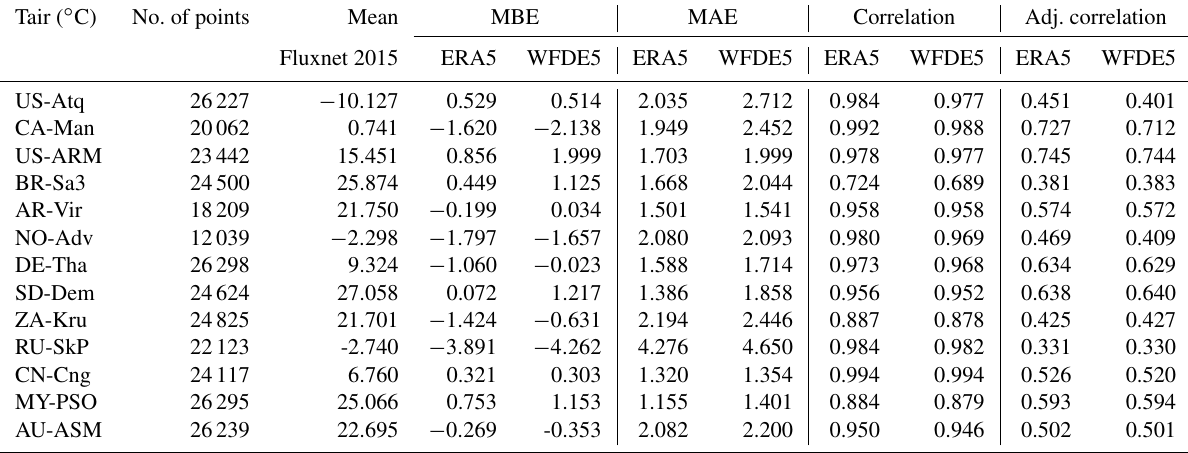
Table A1. Tair metrics for each FLUXNET2015 site: ERA5 versus FN2015 and WFDE5 versus FN2015 at hourly time steps. Tair ( ◦ C)